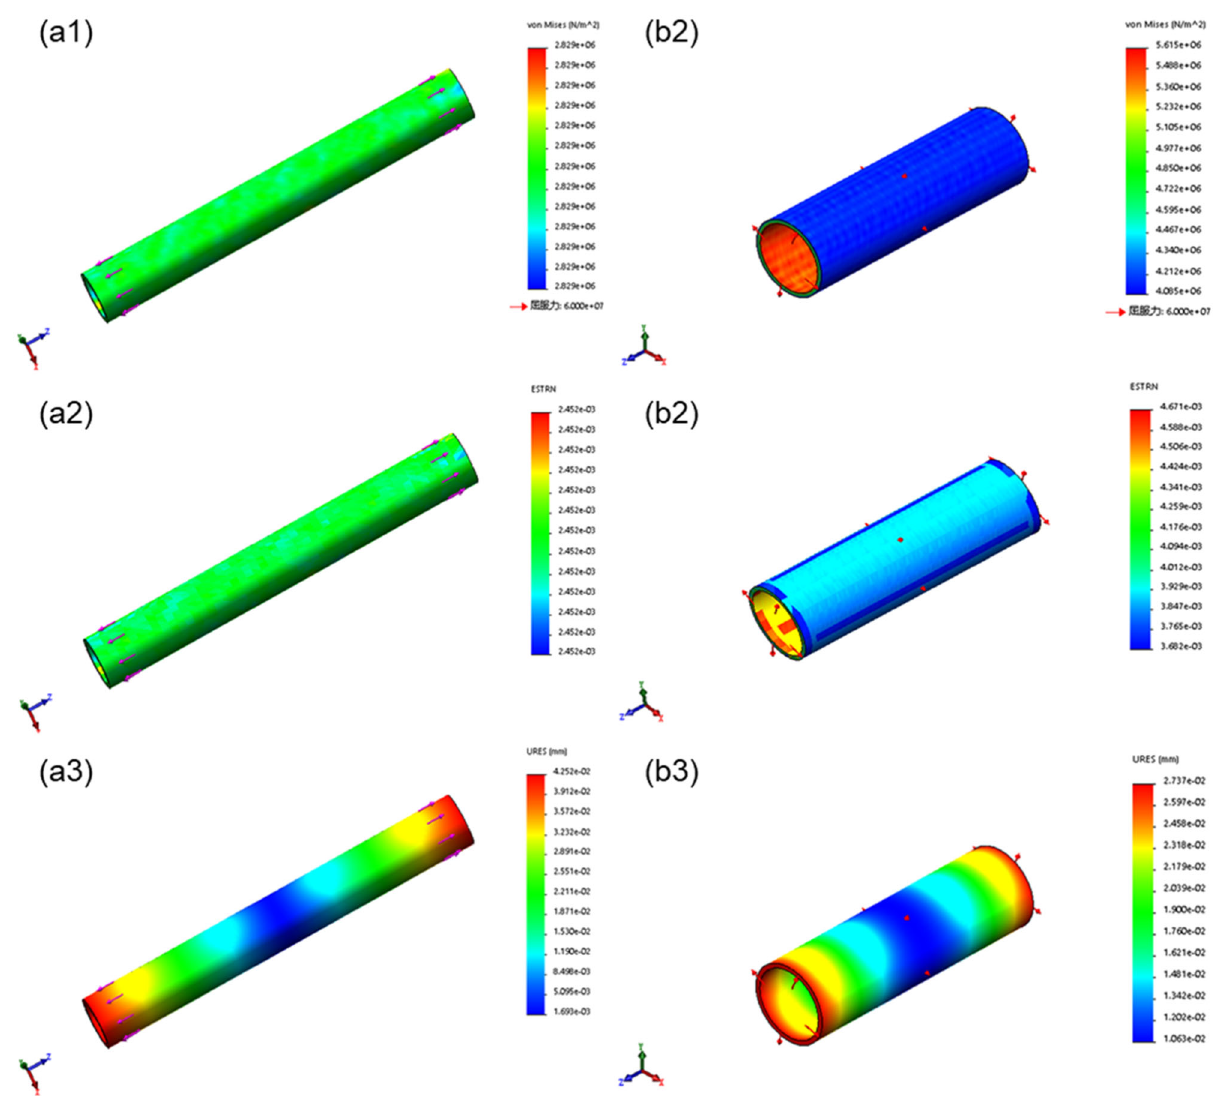
Fig. 5 Mechanical simulation of bioarti fi cial blood vessel without thorn-like protrusions: a1 Axial stress, a2 Axial strain. a3 Axial displacement. b1 Radial stress. b2 Radial strain. b3 Radial